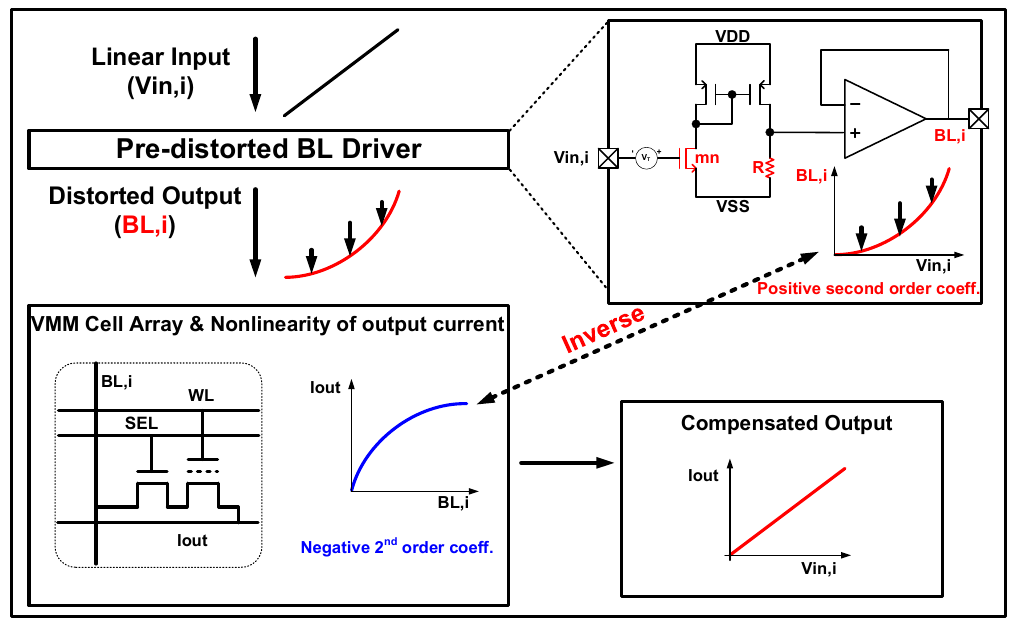
Figure 6. Linearity improvement of the current behavior using a pre-distorted BL driver.